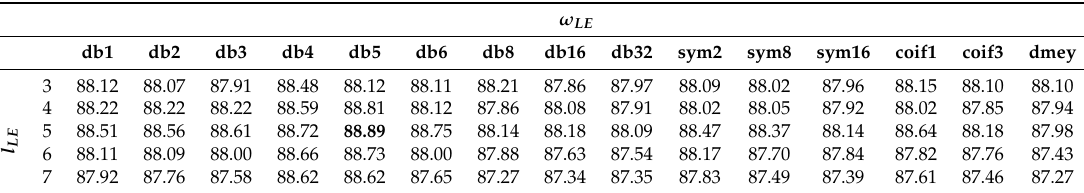
Table 16. The accuracy (%) of three class sleep stage classification with different ω LE and l LE under R&K